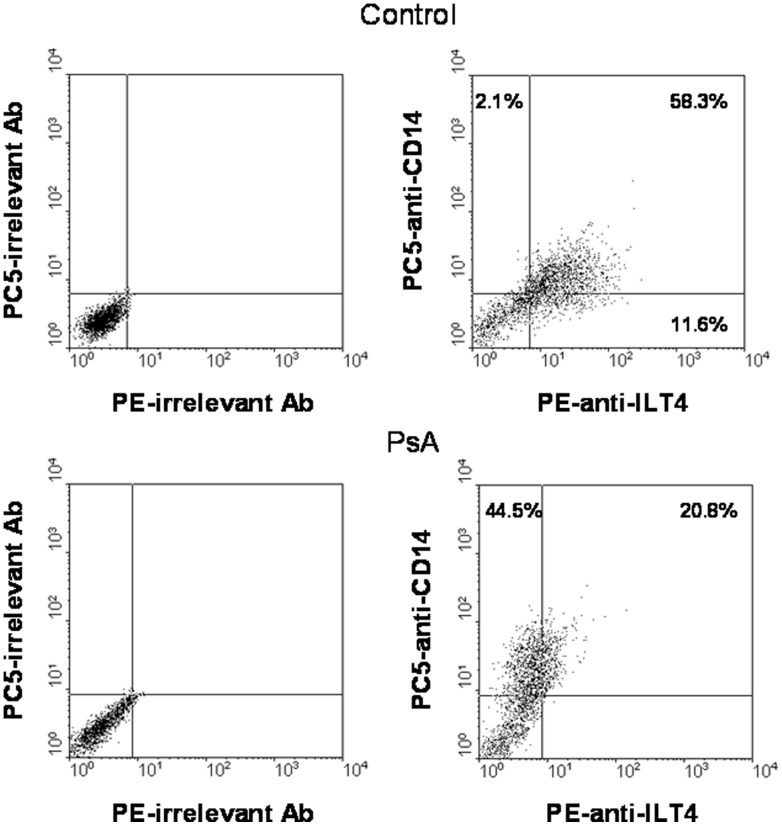
Measurement of ILT4 expression in a representative control subject and a patient with PsA.Dot plots showing CD14/ILT4 co-expression in CD40L monocytes from representative control and PsA subjects.